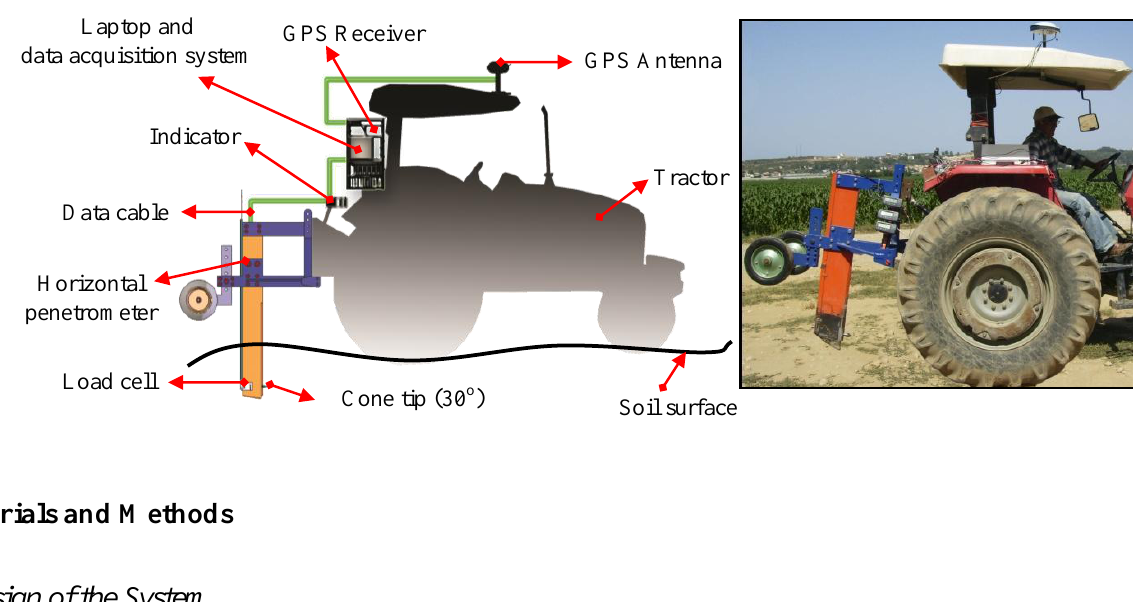
Figure 1. Structure of the designed